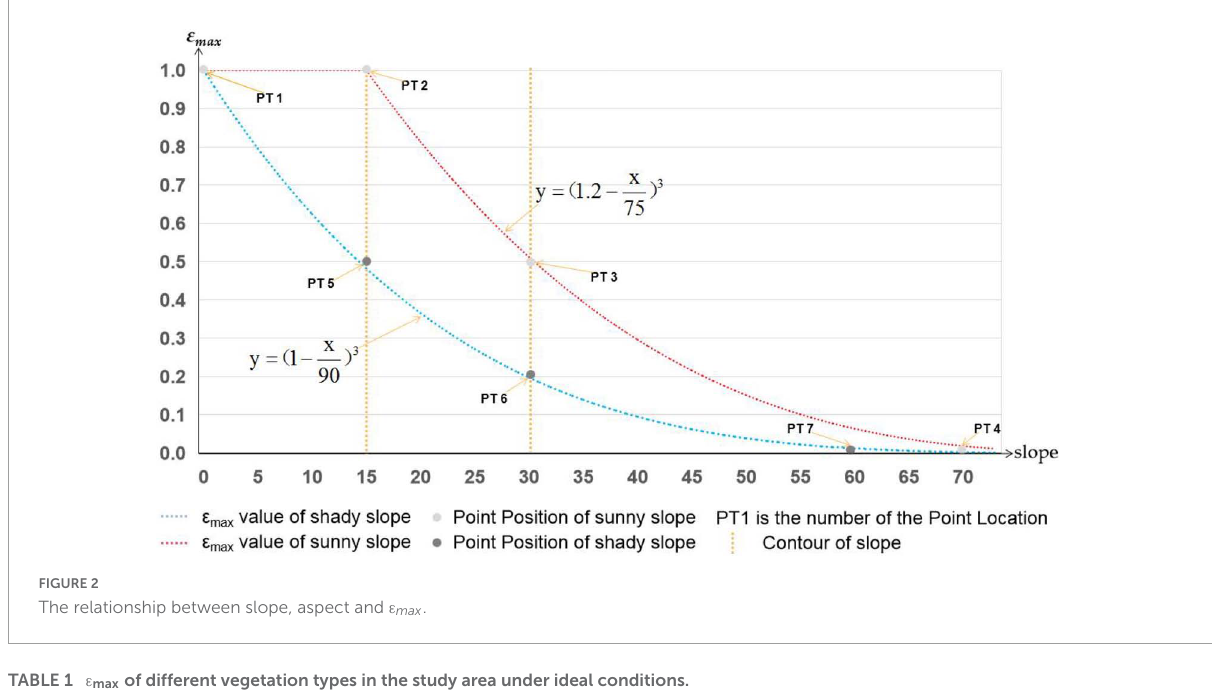
TABLE 1 ε max of different vegetation types in the study area under ideal